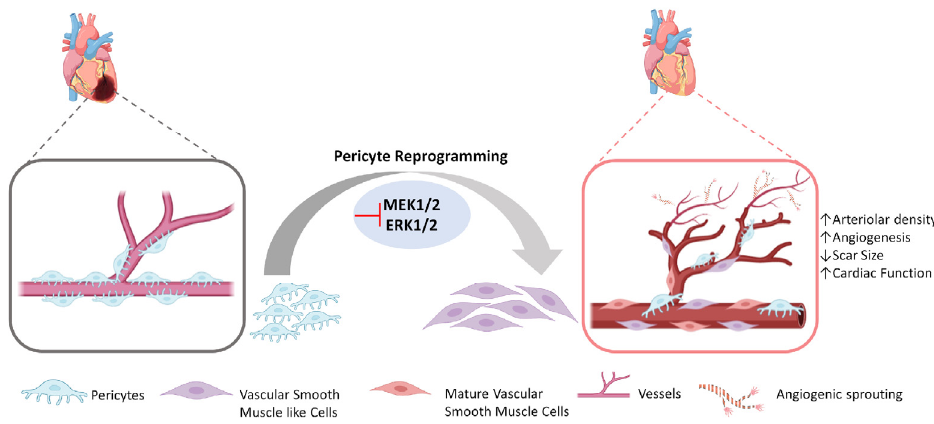
Figure 3. Direct reprogramming of cardiac pericytes into vascular smooth muscle like cells and their potential for angiogenesis. In the injured heart, resident cardiac pericytes can be reprogrammed into vascular smooth muscle like cells that gradually mature and contribute to angiogenesis and arteriogenesis.